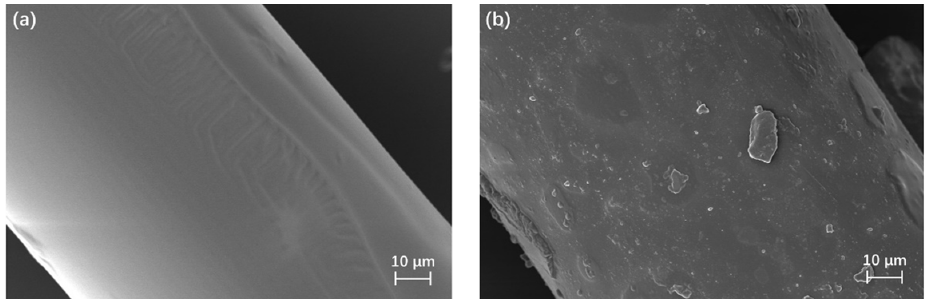
Figure 5. The microscopic morphology of PEEK fibers; ( a ) Unmodified surface of PEEK fibers, ( b ) Surface of PEEK fibers modified with KH550.